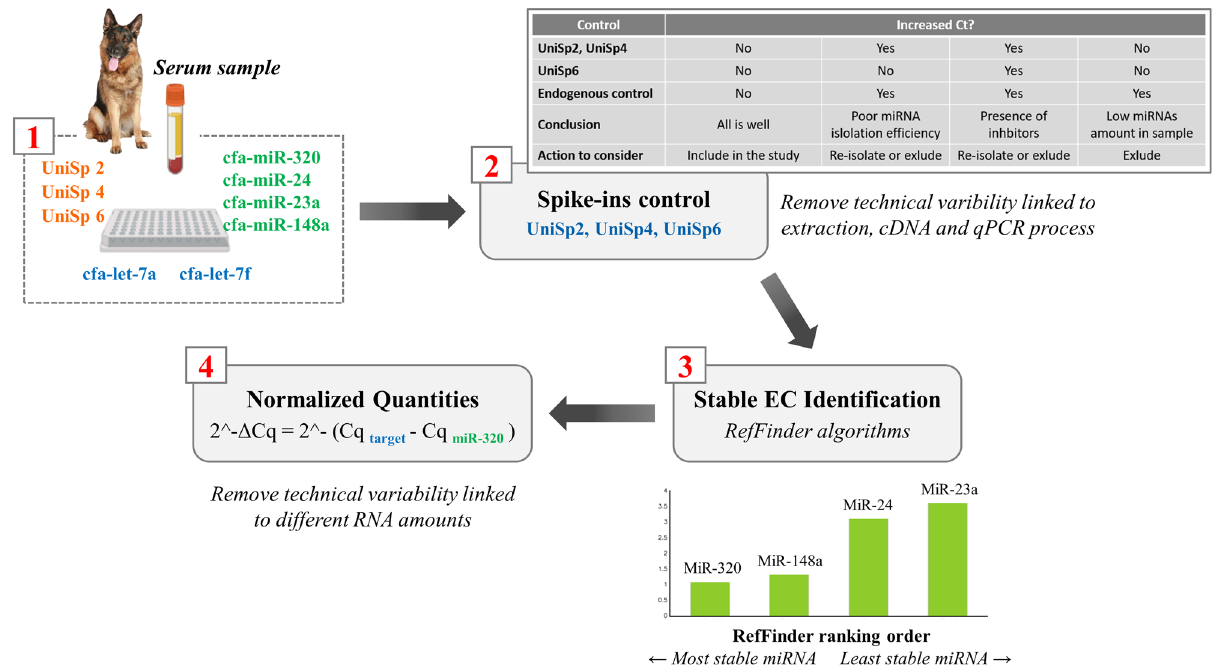
Figure 5. Control of qPCR data. In all serum sample, qPCR reaction was performed by amplifying 9 targets: let-7a and let-7f differentially expressed miRNAs, UniSp 2, 4, 6 Spike-in, and the EC miR-191, miR-423a, miR- 93, and miR-425. UniSp2, UniSp4, UniSp6 enable confident interpretation, first data control (1 red). Spike-ins were compared, and the outlier was detected for sample exclusion or re-isolation. UniSp Cq was interpreted as described by QIAGEN in “Guidelines for Profiling Biofluid miRNA” (summarized in the table). The second data control was miRNAs normalization with the most stable miRNA EC (identified as mir-320). The figure is created by G. Guelfi using PowerPoint 2021, Microsoft Corporation,